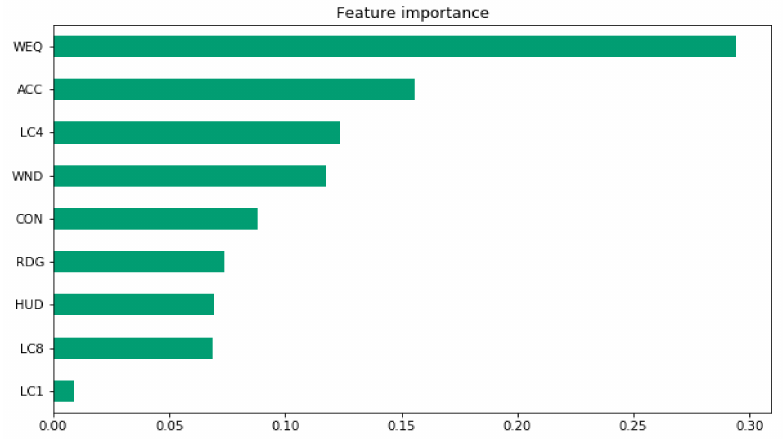
Figure 5. Feature importance values for the selected set of explanatory variables (Table 2), showing contributions to the boosted regression tree model. These values collectively sum to one across model variables. In order of decreasing feature importance, the top four variables are directional wind power equitability (WEQ), urban accessibility (ACC), forested land cover (LC4), and dimensionless wind energy